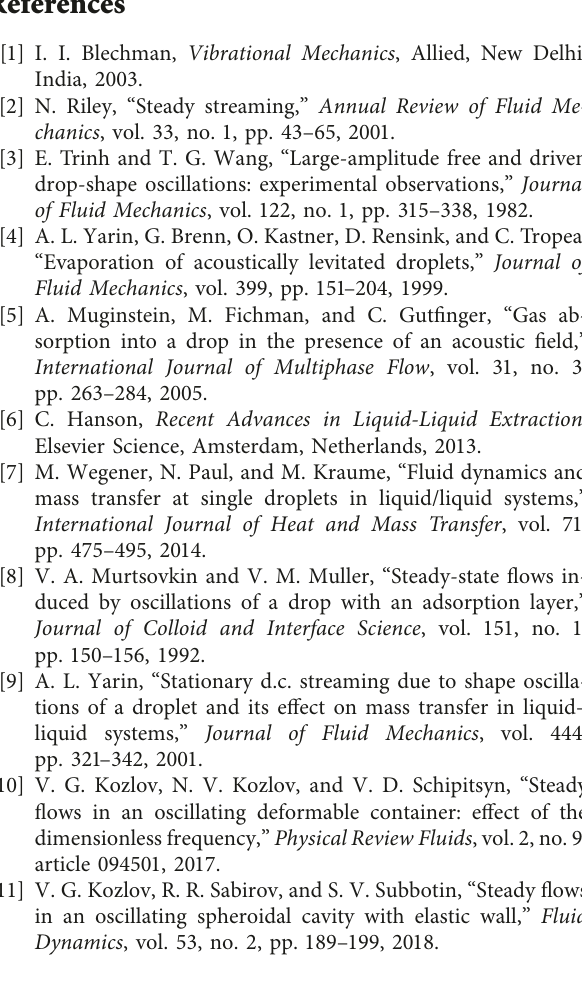
are obtained 01 − 04